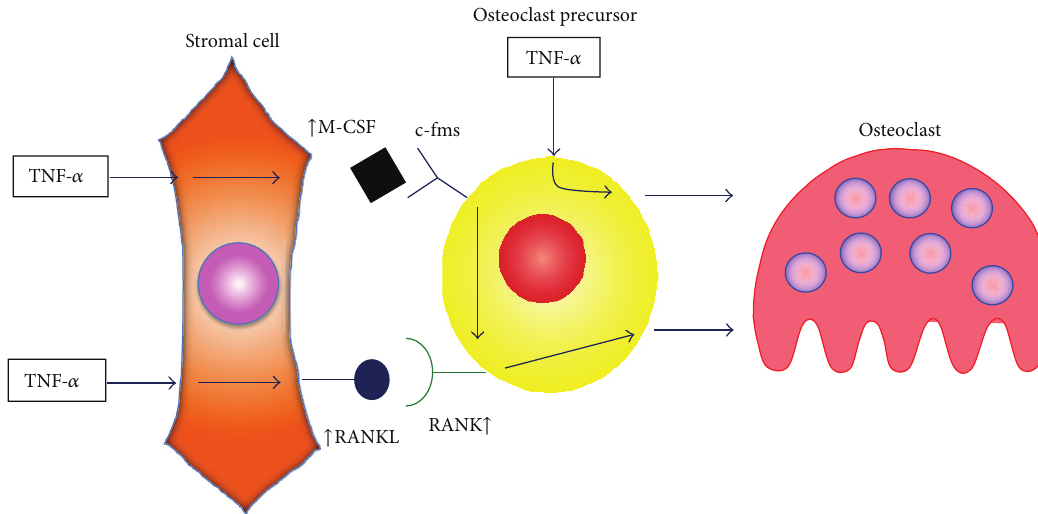
Figure 1: Contribution of macrophage and stromal cell in TNF- 𝛼 -mediated osteoclastogenesis. TNF- 𝛼 stimulated expression of RANKL and M-CSF in stromal cell, and the stromal cell induced osteoclastogenesis. Also, TNF- 𝛼 directly induced osteoclastogenesis to osteoclast precursor in the presence of constitutive level of RANKL and TNF- 𝛼 -induced M-CSF stimulate expression of RANK in osteoclast